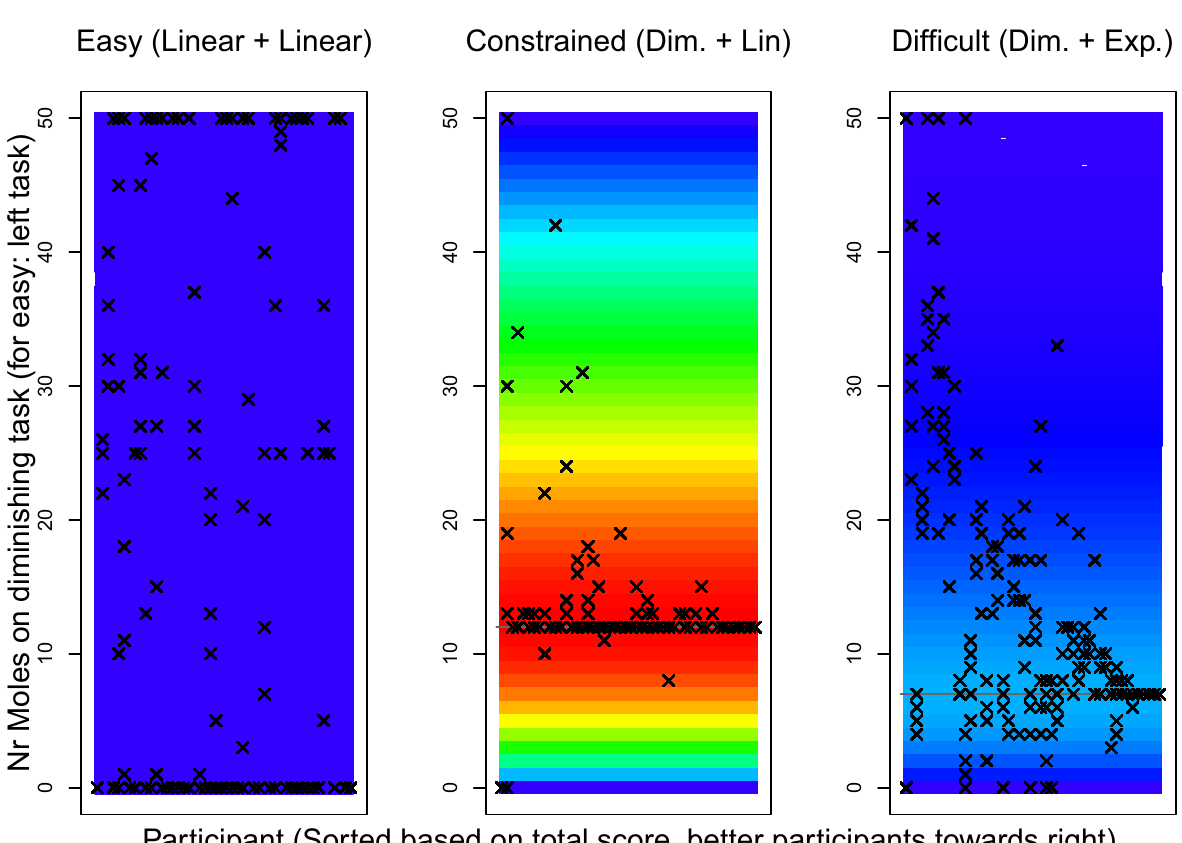
Fig 3. Heatmaps of the predicted score for interleaving tasks at a specific division with human data. For the easy task, the y-axis shows the number of moles whacked on the left task, for the other two scenarios the y-axis shows the number of moles whacked on the tasks with diminishing return rewards. Crosses show the strategies that participants applied during the last five trials of each scenario. Participants (horizontal axis) are sorted based on their total score for the trials that contributed towards their score, with better participants towards the right. In the easy and difficult scenario there is variation in the strategies that are applied between and within subjects. In the constrained scenario there is little variation, as participants found the optimal strategy and applied this.